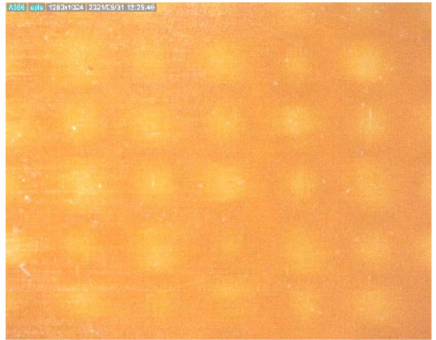
Figure 2. MO image of the surface of the reference sample textolite material (40 times magnification). The lighter weave of the support fabric is visible as fibreglass under a transparent resin layer.